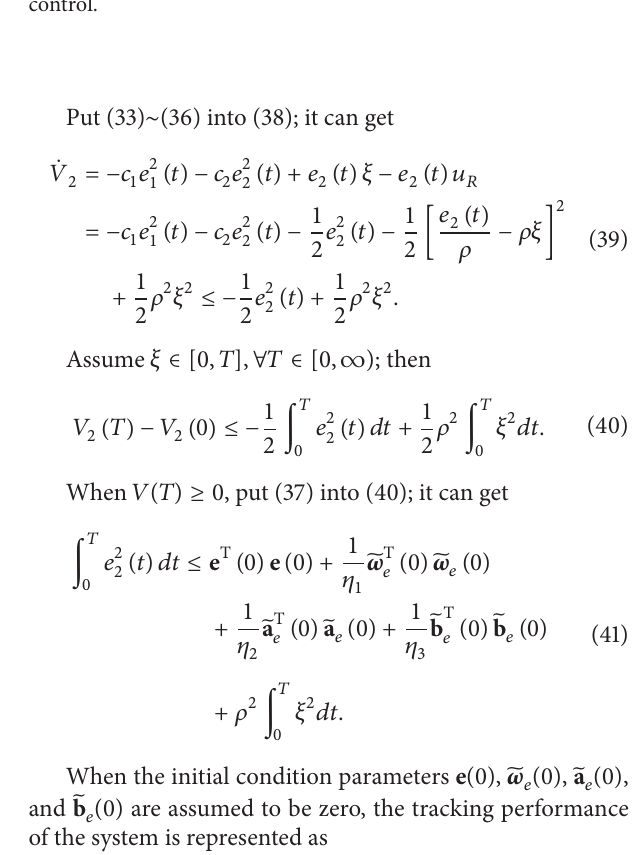
Figure 3: Self-organizing wavelet CMAC adaptive